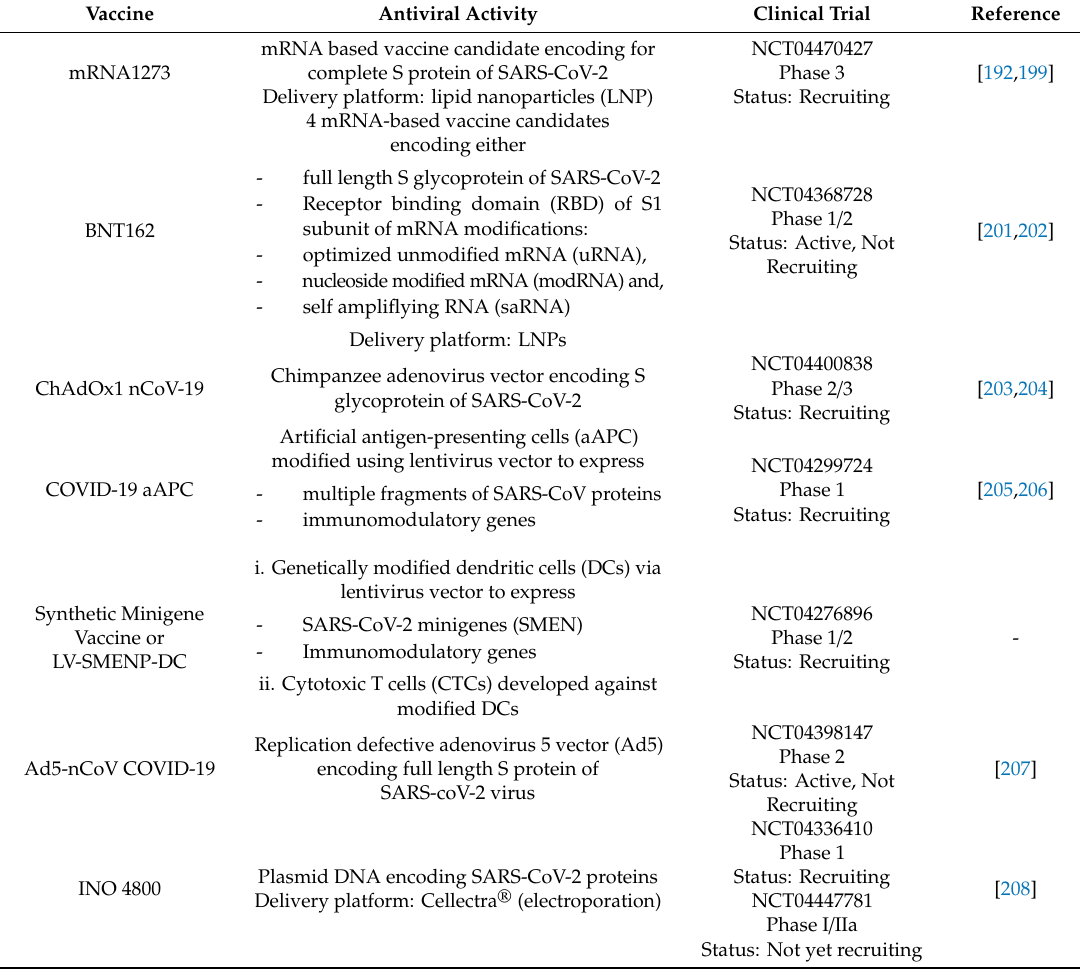
Table 3. Description of SARS-COV-2 vaccine candidates currently in clinical trials. Vaccine Antiviral Activity Clinical Trial